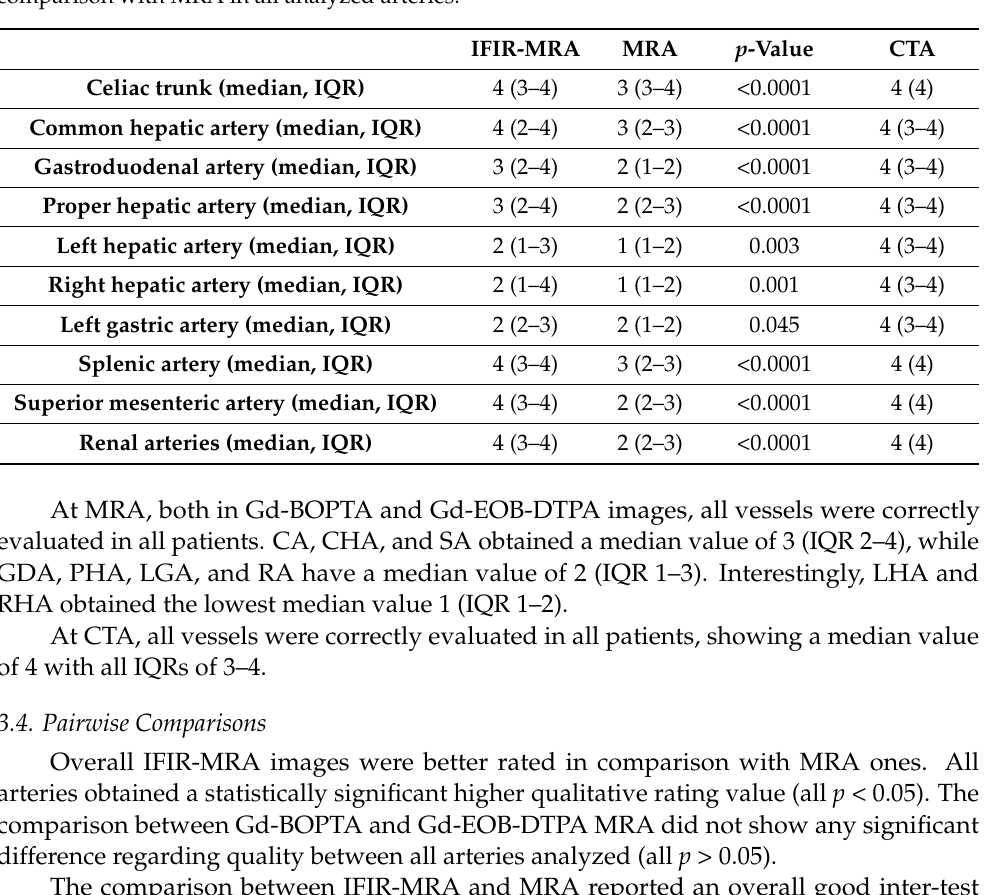
Table 1. Median and IQR values of subjective image quality of IFIR-MRA, MRA and CTA images by the most experienced reader. IFIR-MRA images obtained an overall higher image quality in comparison with MRA in all analyzed